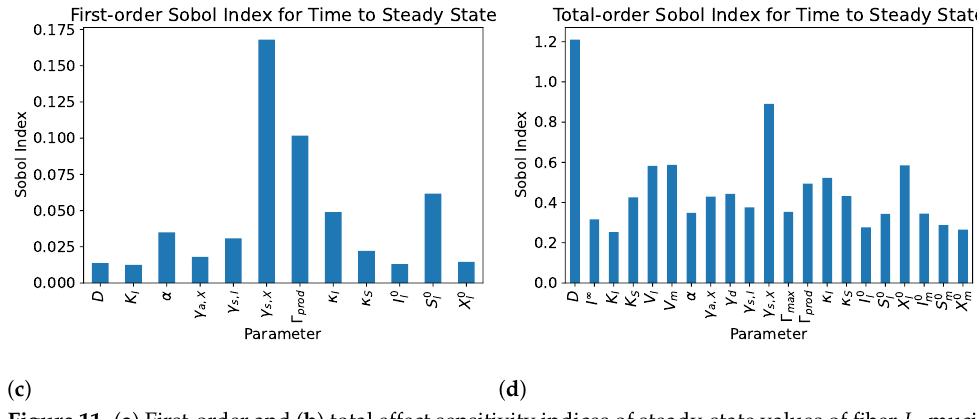
Figure 11. ( a ) First-order and ( b ) total effect sensitivity indices of steady-state values of fiber I l , mucin I m , luminal sugar S l , mucosal sugar S m , luminal biomass X l and mucosal biomass X m . Parameters with sensitivity indices below 0.1 for all variables were omitted for ( a , b ). ( c ) First-order and ( d ) total effect sensitivity indices of time to steady state of fiber I l , mucin I m , luminal sugar S l , mucosal sugar S m , luminal biomass X l and mucosal biomass X m . Parameters with sensitivity indices below 0.01 were omitted for ( c , d ). Sampling was conducted with a variance of 80% on input parameters to capture the saddle-node bifurcation (Figure 7), excluding yield coefficients. Mean values were taken from Table